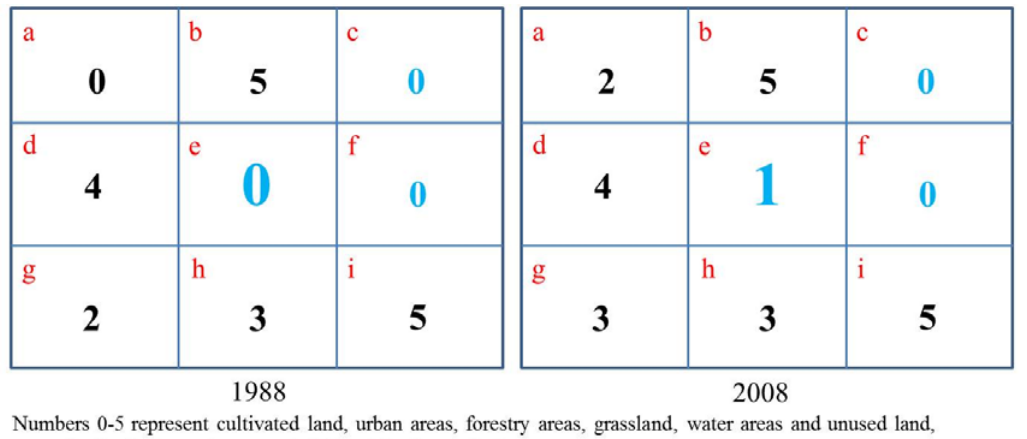
Figure 2. The mechanism distinguishing the effects of land use change from climate change on ESV.